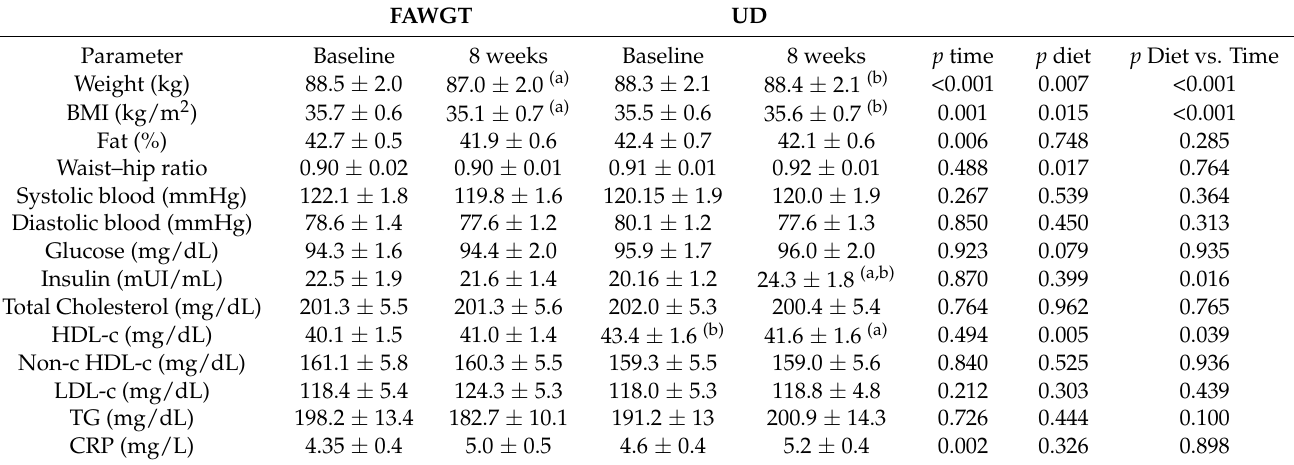
Table 1. Characteristics of subjects included in the study in fasting, after and before the dietary